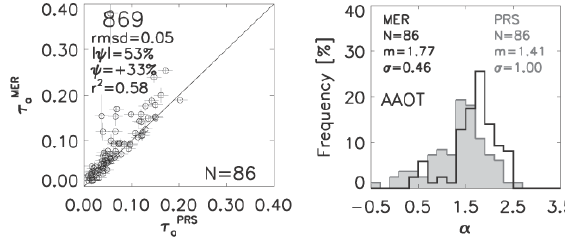
Fig. 11. Scatter plots of MERIS (MER) and AERONET-OC (PRS) τ a (869) match-ups for the AAOT determined with 1t =± 1h (left panel), and corresponding frequency distributions (right panel) of α determined with τ a at 779 and 869nm from MERIS data and at 670 and 869nm from AERONET-OC data. Data are from the 2nd Reprocessing. The horizontal bars in the scatter plot indicate the estimated uncertainty in AERONET-OC τ a while vertical bars in- dicate ± 1 standard deviation of the 3 × 3 values utilized for com- puting MERIS τ a . The black characters and lines in the frequency distribution plot, indicate results from the analysis of MERIS data while grey characters and solid bars indicate results from the analy- sis of AERONET-OC data ( N is the number of match-ups, m is the median and σ the standard deviation).